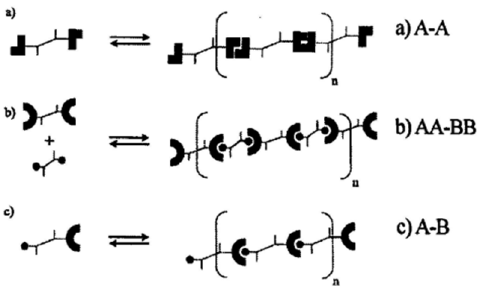
Figure 6. Schematic representation of supramolecular polymers assembled from self-complemen- tary.